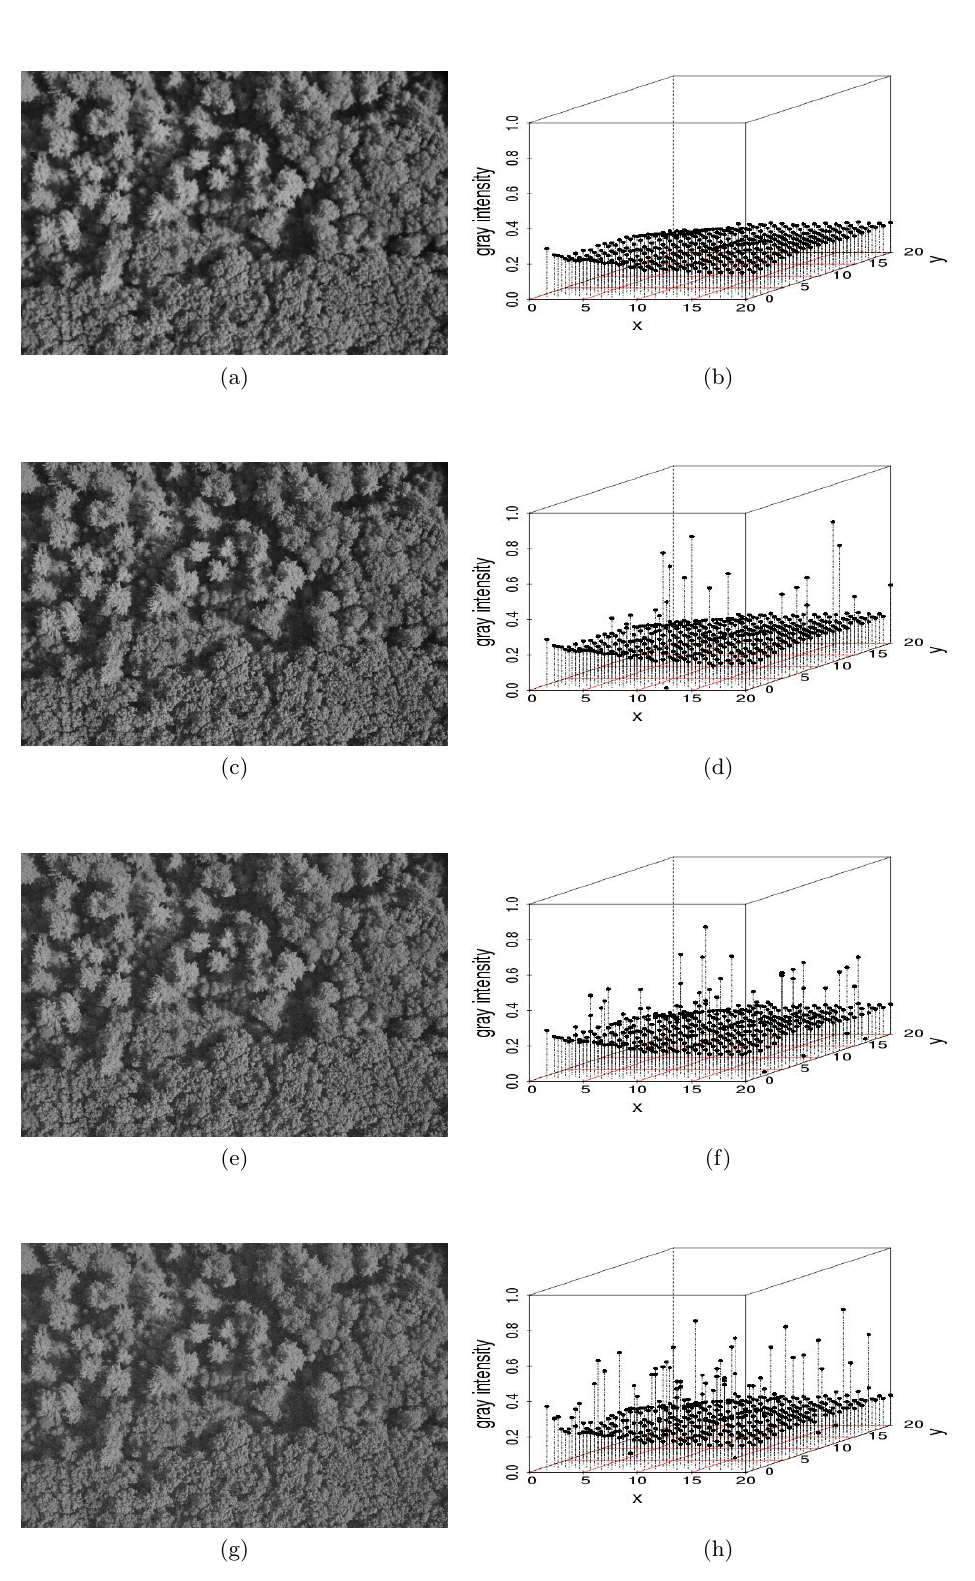
Figure 1. ( a ) reference image of size 5616 × 3744 pixels taken above a section of forest at the Harvard Forest, Petersham, MA, USA and ( b ) its corresponding gray scale values. ( c , e , g ) are the same image distorted with increasing amounts of salt-and-pepper noise. The percentages of contamination are 5%, 10%, and 25%, respectively; ( d , f , h ) show the change in gray intensity after the addition of salt-and-pepper noise to the